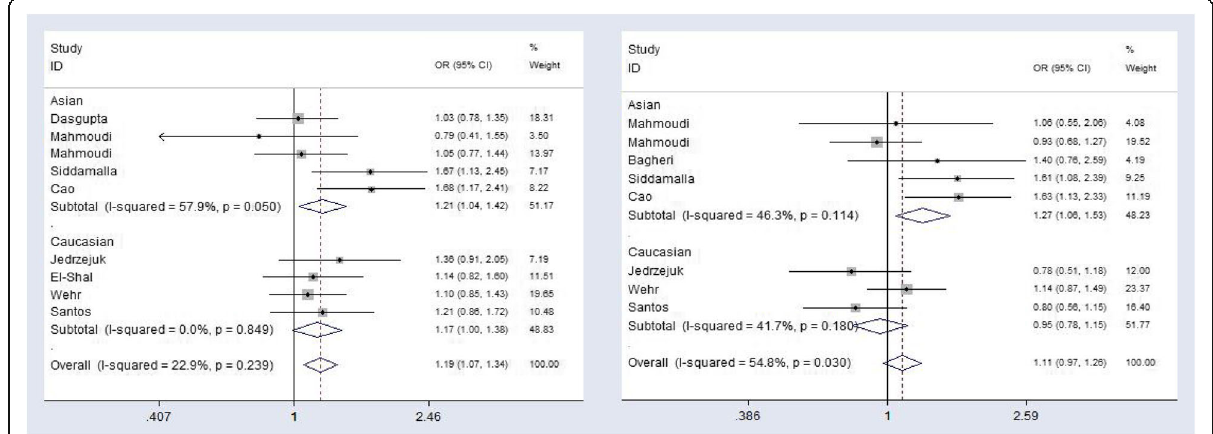
Fig. 2 Forest plots of the VDR polymorphisms and PCOS in the overall populations. VDR ApaI (rs7975232) with allelic model: C vs. A; and VDR BsmI (rs1544410) with allelic model: G vs.